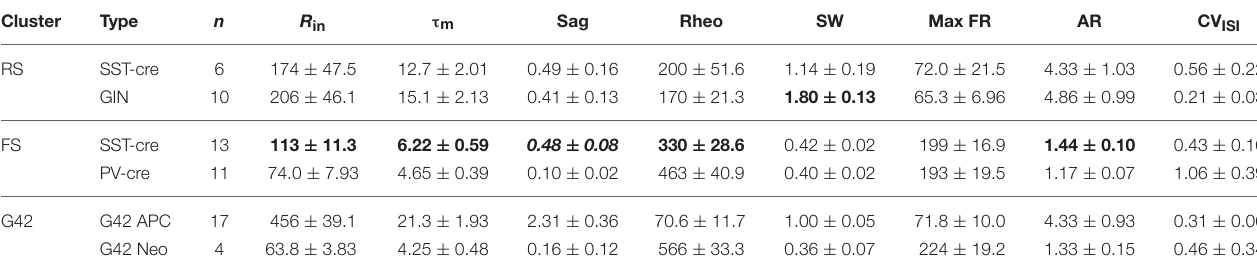
TABLE 1 | Intrinsic properties of identified interneurons in SST-Cre, PV-Cre, GIN, and G42 transgenic lines. Cluster Type n R in τ m Sag Rheo SW Max FR AR CV ISI RS SST-cre 174 ±